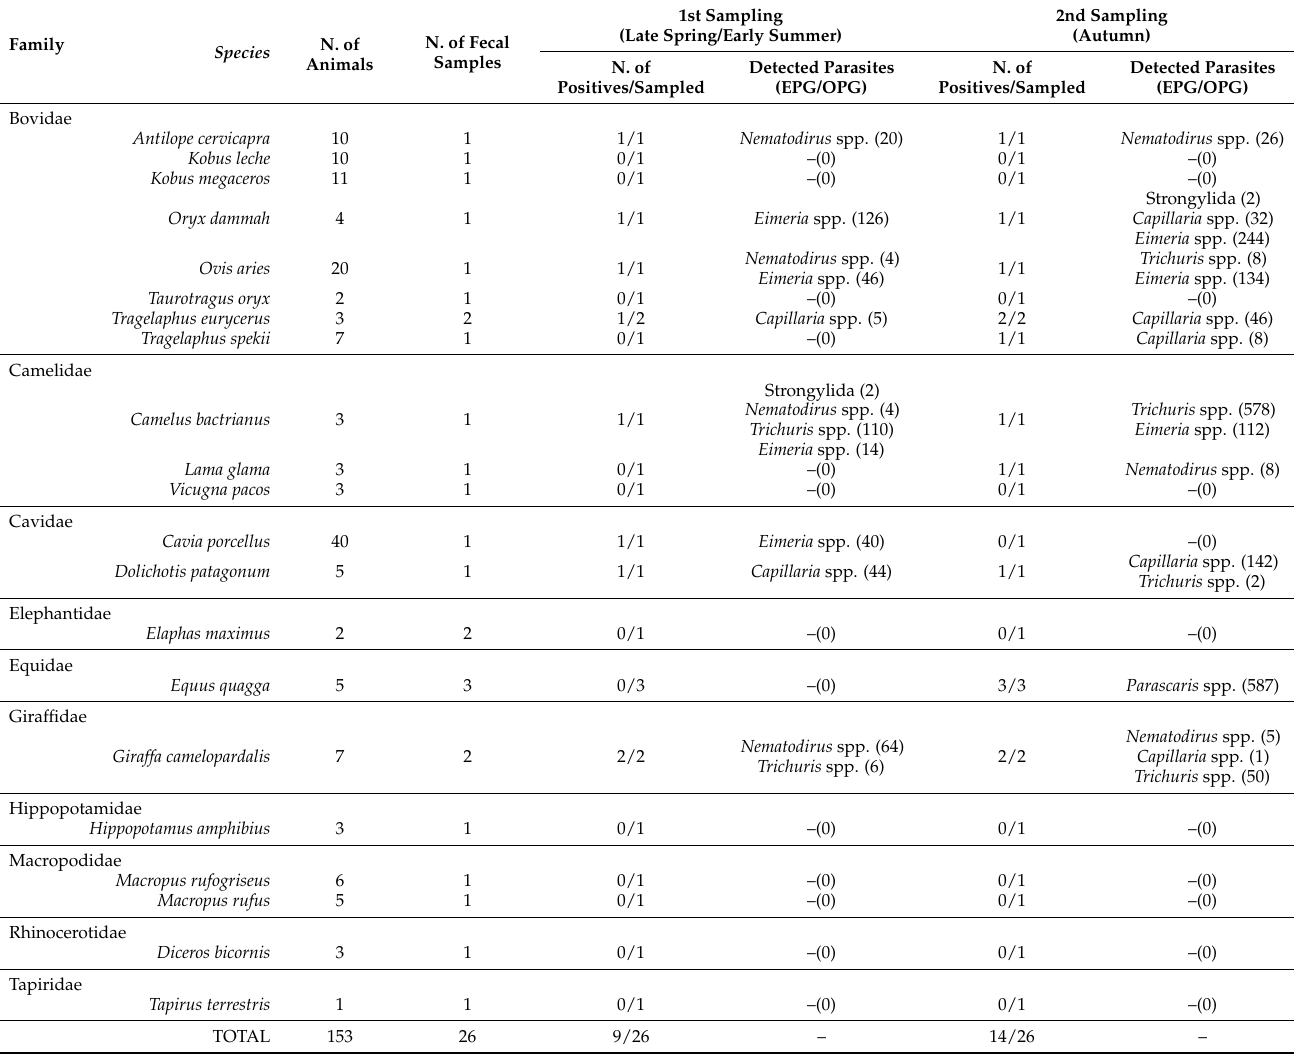
Table 1. Endoparasites detected by quali/quantitative copromicroscopic analyses (FLOTAC ® dual technique) in herbivores from a faunistic park in northern Italy. When more than one sample for species is tested, EPG/OPG is the mean